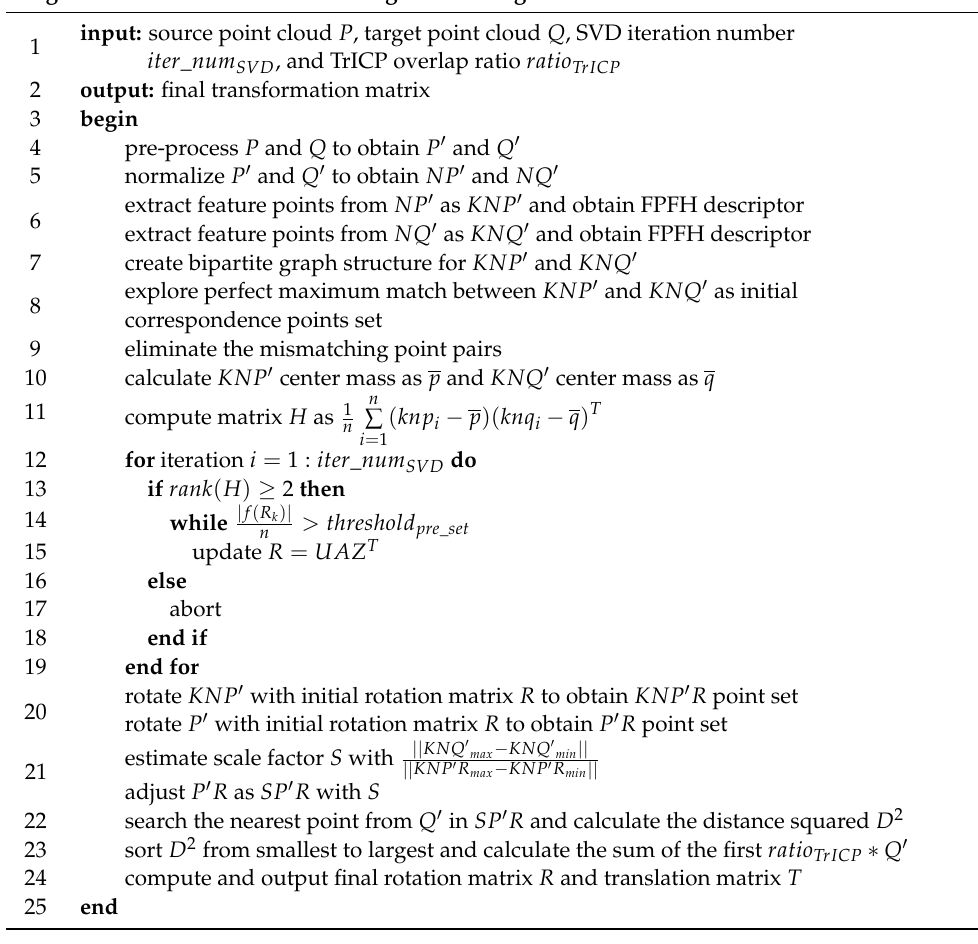
Algorithm 2. The Coarse-to-Fine Registration